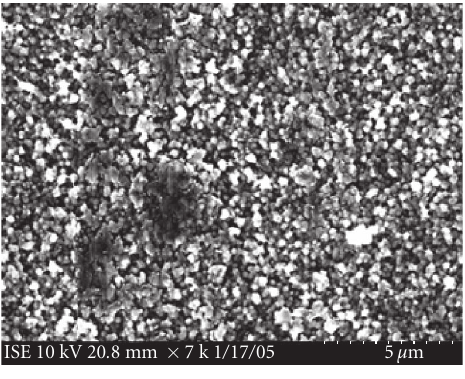
Figure 2: SEM of the first layer.